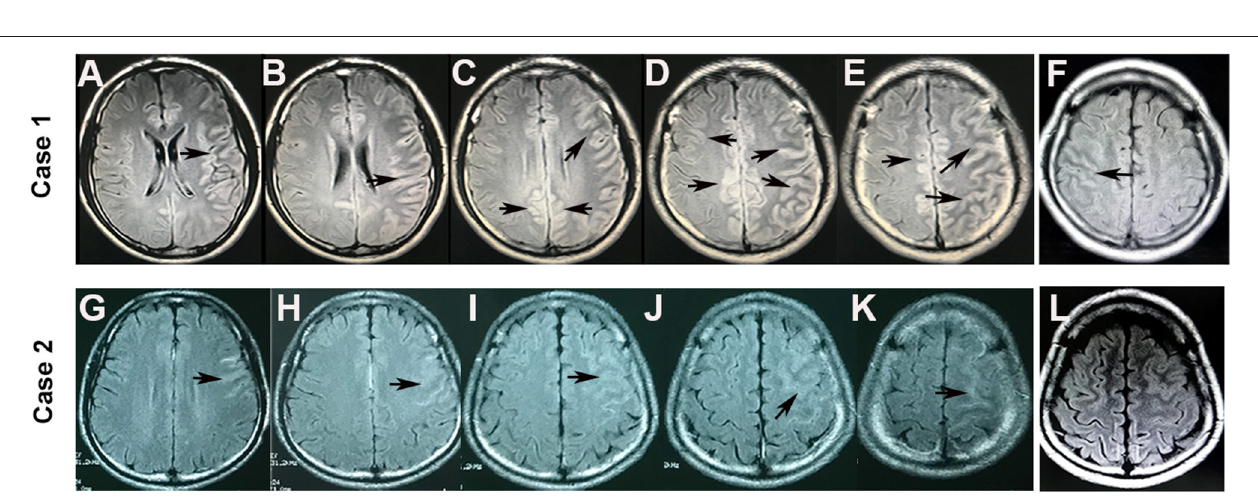
FIGURE 2 | Brain MRI of cortical lesions in cases 1 and 2. FLAIR hyperintensity was seen in the bilateral cerebral cortex in case 1 (A–E) and in the left hemispheric cortical region in case 2 (G–K) (arrowheads). However, the FLAIR hyperintensities in the cortical regions became shallow and fewer after 3 months in case 1 (F) and disappeared after 1 month in case 2 (L)